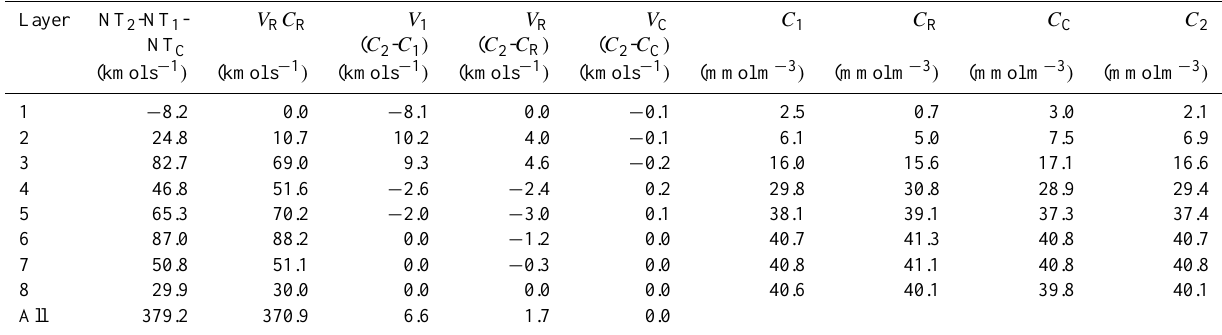
Fig. 7. Schematic of a budget model for an area enclosed by (a) sections ASUKA-N and 137E-N-S and (b) by sections ASUKA-N, TK and OK-W. V: volume transport; NT: nitrate transport; C: ratio of NT to V. (a) Subscript “1” denotes section ASUKA-N; subscript “2” denotes section 137E-N-S; subscript “C” denotes section 137E-N-N where a westward coastal current flows into the area enclosed by sections ASUKA-N and 137E-N-S; and subscript “R” denotes a section (red dashed line) where the Kuroshio recirculation flows into the area enclosed by sections ASUKA-N and 137E-N-S. (b) Subscript “1” denotes section TK; subscript “2” denotes section ASUKA-N; subscript “0” denotes section OK-W; and subscript “R” denotes a section (red dashed line) where the Kuroshio recirculation flows into the area enclosed by sections ASUKA-N, TK and OK-W. Table 2. Budget of nitrate transport (kmols − 1 ) for each isopycnal layer between sections 137E-N-S and